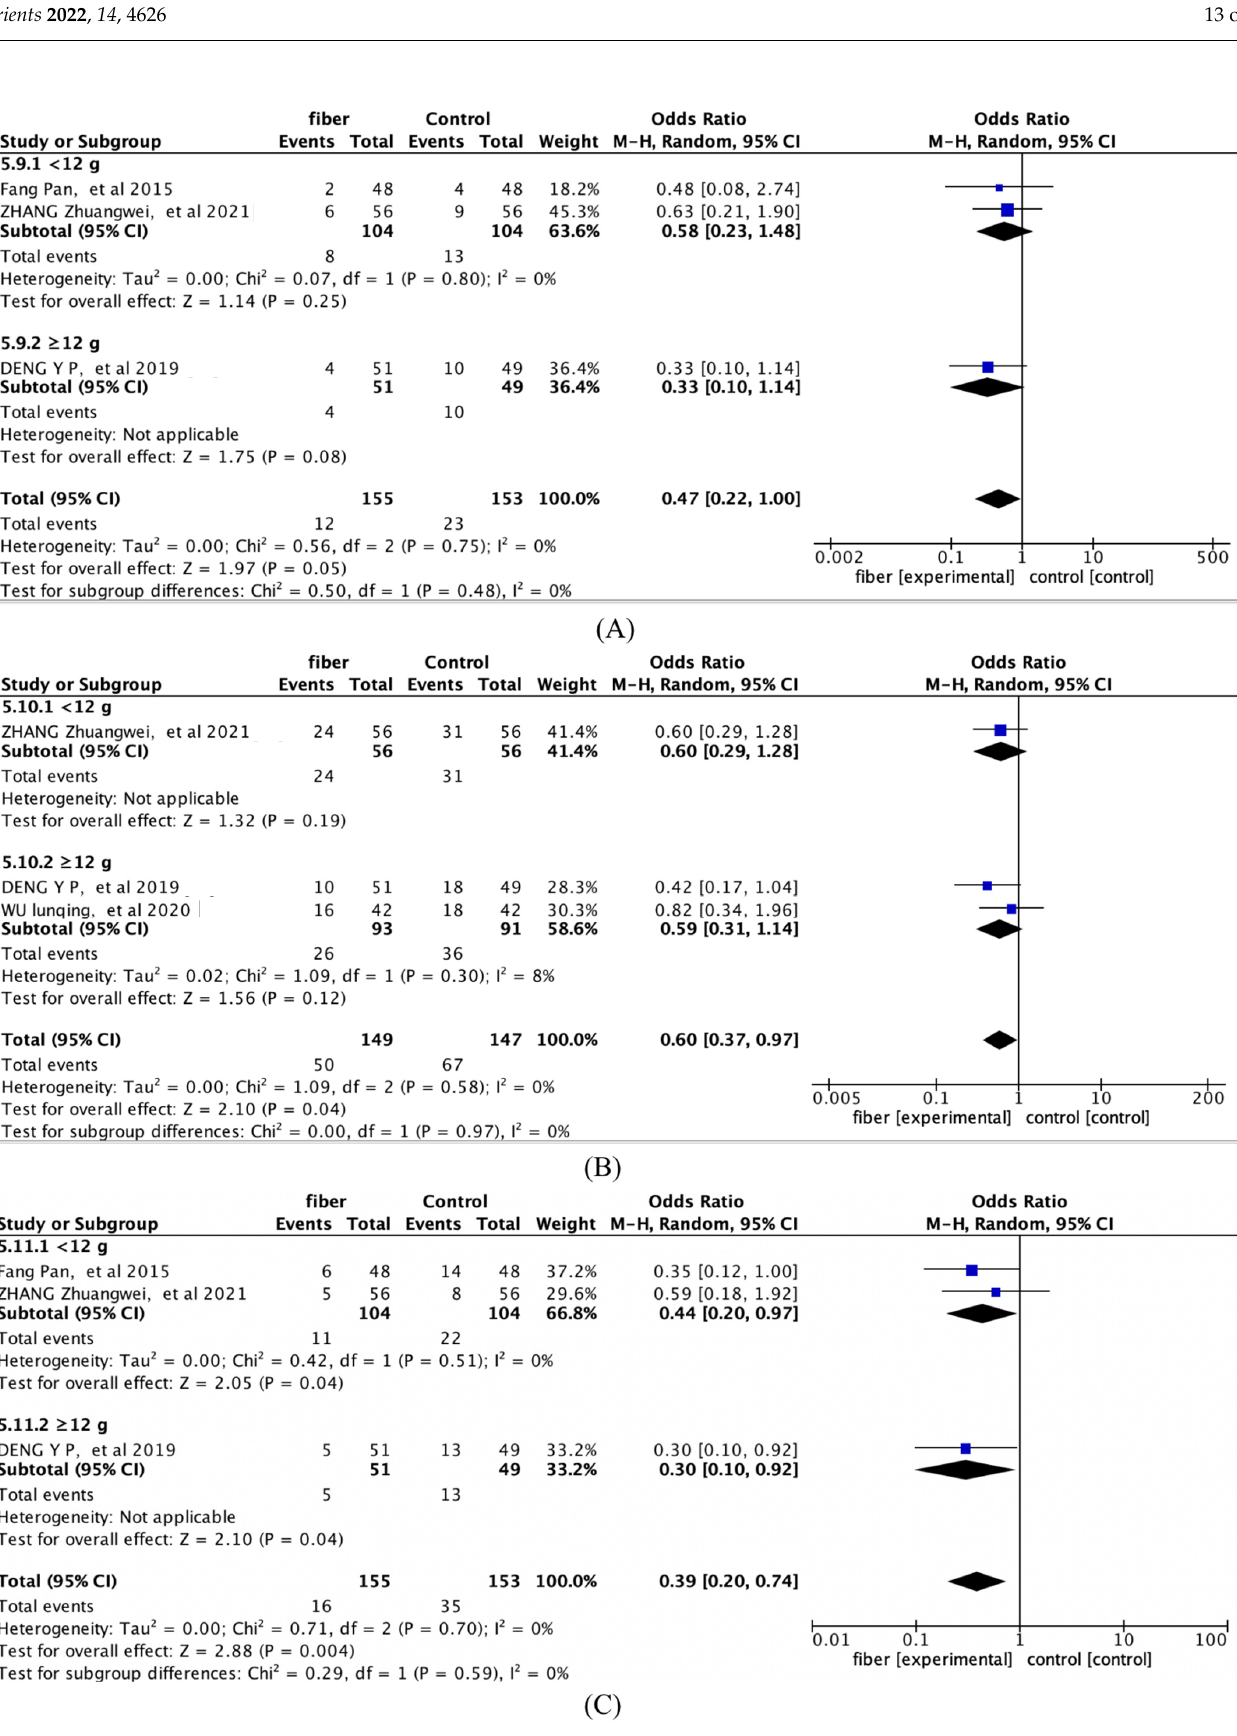
Figure 9. Forest plots of subgroup analysis of fiber quantity on ( A ) preterm deliveries, ( B ) cesarean deliveries, and ( C ) macrosomia